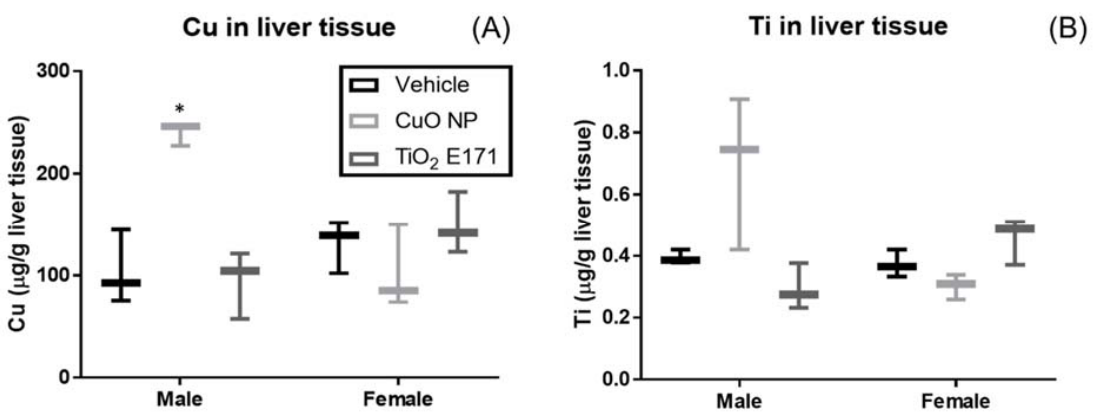
Figure 4. ICP-MS data of liver tissue collected 4 h after administration of the fourth and last dose on PND 10 show- ing the tissue concentration of Cu ( A ) and Ti ( B ). The concentration of Cu and Ti was determined for all three dosing groups. ICP-MS data presented as mean ± standard deviation. Box and whisker plots of metal concentration are shown. Statistical difference between vehicle control and dosing groups are noted by asterisk(s); p -value < 0.05 is noted with one asterisk.